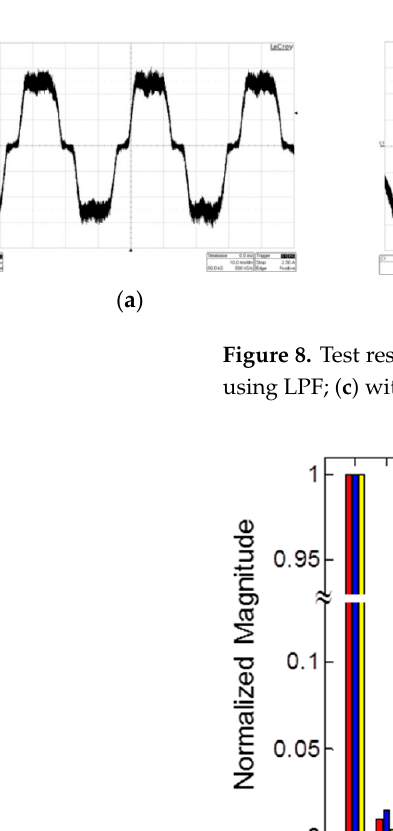
Figure 7. Polarity check with LPF and hysteresis band.